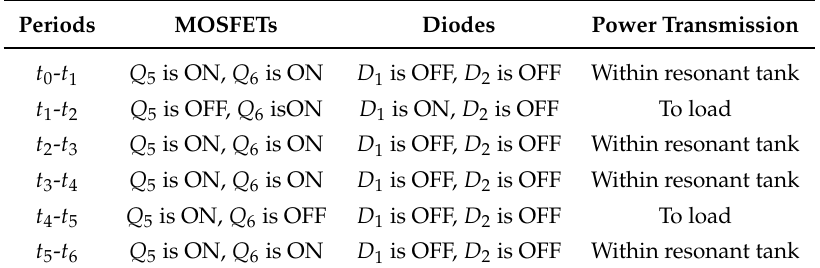
( a ) Circuit of semi-bridgeless active rectifier (S-BAR). ( b ) Block diagram of DPSK based modulation. Table 1. Control strategy for power devices during one switching